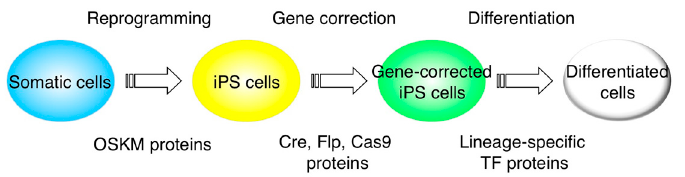
Figure 1. CPP-mediated protein transduction technologies in reprogramming, gene editing/correction, Figure and differentiation of iPS cells. CPP-mediated protein transduction methods are used for key steps in iPS cell technologies. The reprogramming of somatic cells is induced with Yamanaka-4 factors fused to CPPs. Gene correction of disease-specific mutation is performed by the CRISPR-Cas9 system with CPP-fused Cas9 endonuclease. The differentiation of iPS cells is directed with CPP- fused transcription factors. OSKM, Oct4, Sox2, Klf4, c-Myc; TF, transcription factor.